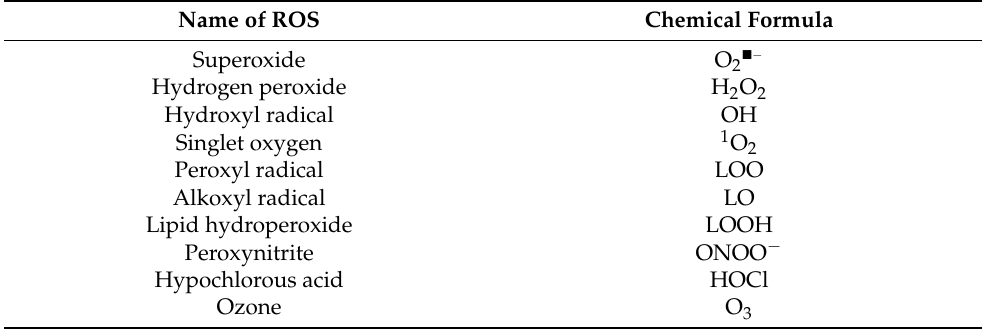
Table 4. Examples of ROS with the most important influence in the cardiovascular system [54,56,59]. Name of